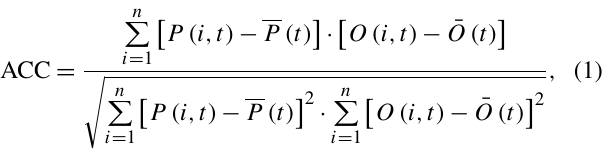
Indirect full-field sea ice initialization (the initial sea ice indirectly influenced by nudging T to SODA ocean reanalysis) Direct full-field sea ice initialization (SIC from